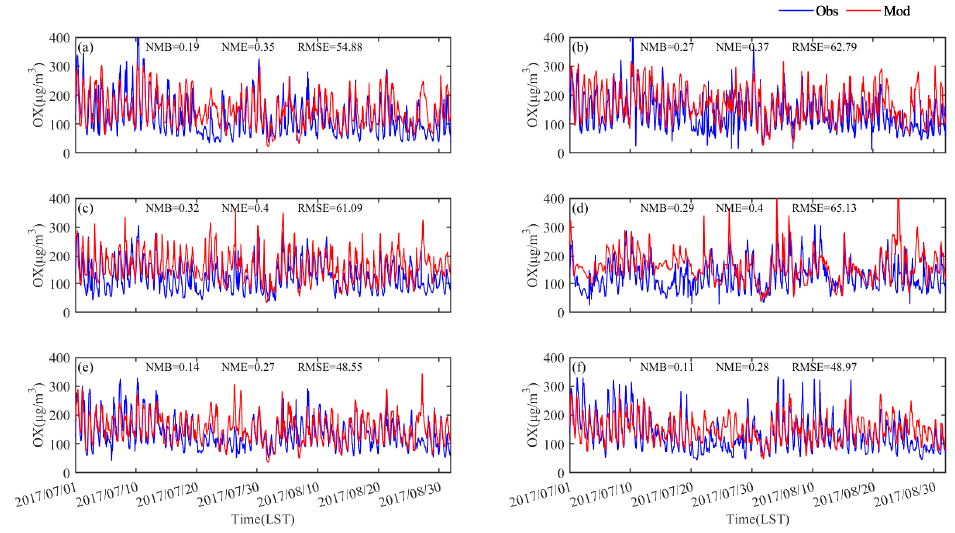
Figure 3. Observed (blue line) and simulated (red line) hourly mean O X (O 3 + NO 2 ) in July and August 2017; ( a – f ) represent the observation sites BJ_1, BJ_2, TJ_1, TJ_2, HB_1, and HB_2, respectively.